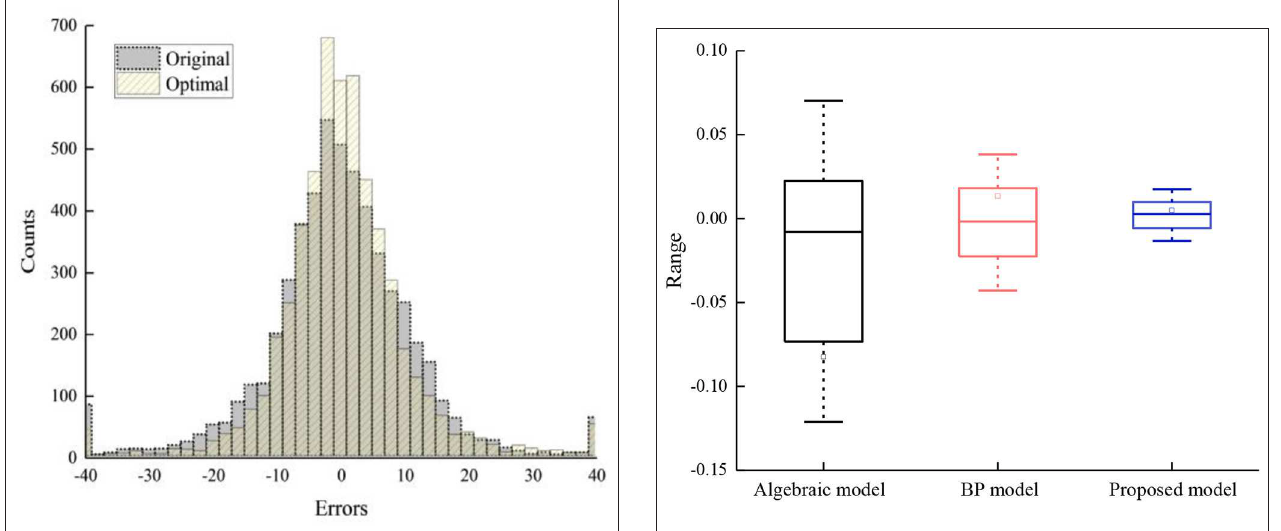
FIGURE 11 | The relative error boxplots for the proposed model and contrasting models.